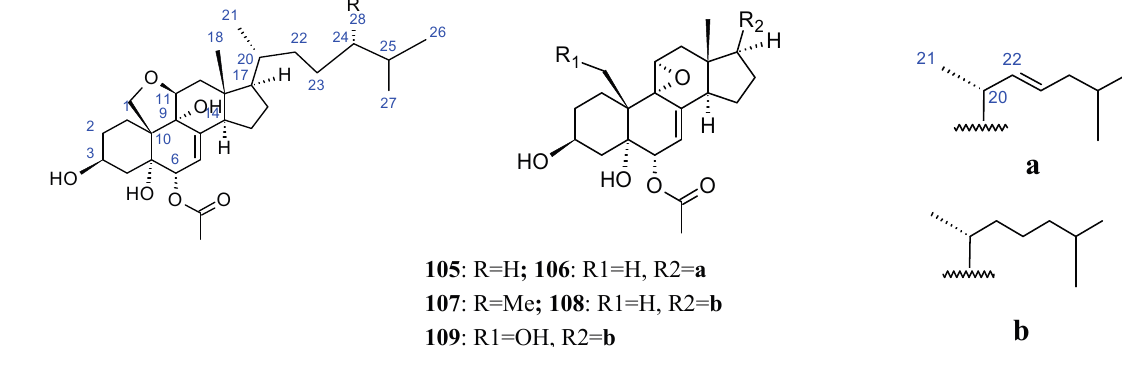
Figure 36. Polyoxygenated steroid dysideasterol